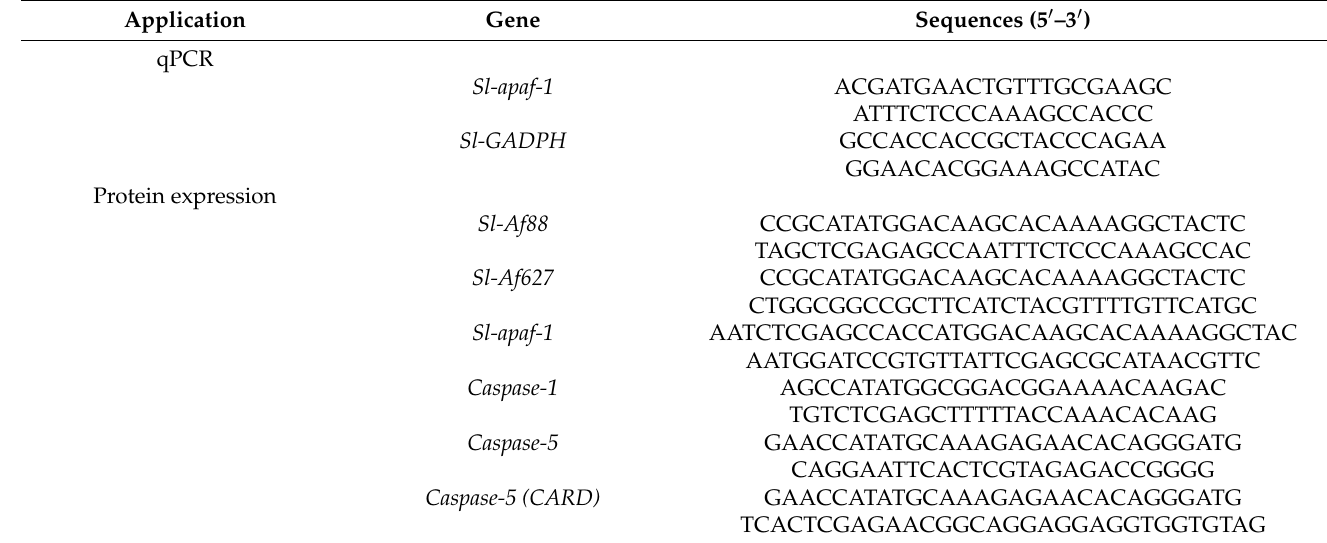
Table 1. Primers used in this